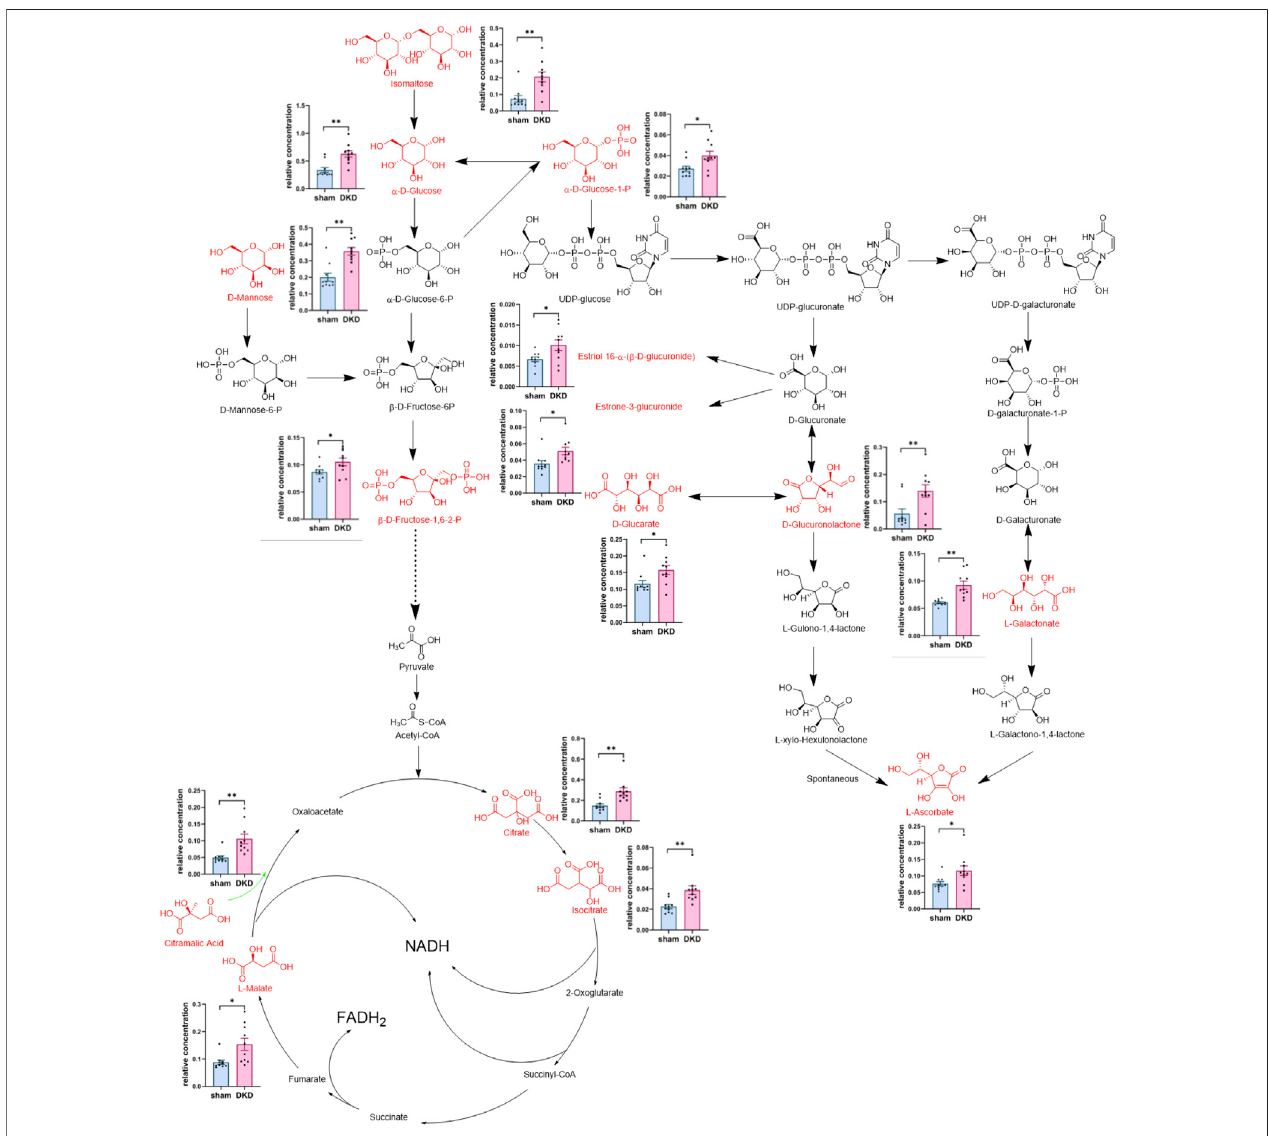
FIGURE 3 | Analysis of 15 markedly elevated metabolites in carbohydrate metabolism. Note: Carbohydrates highlighted in red and their relative concentrations shown in column scatter plot (* p < 0.05, ** p < 0.01).